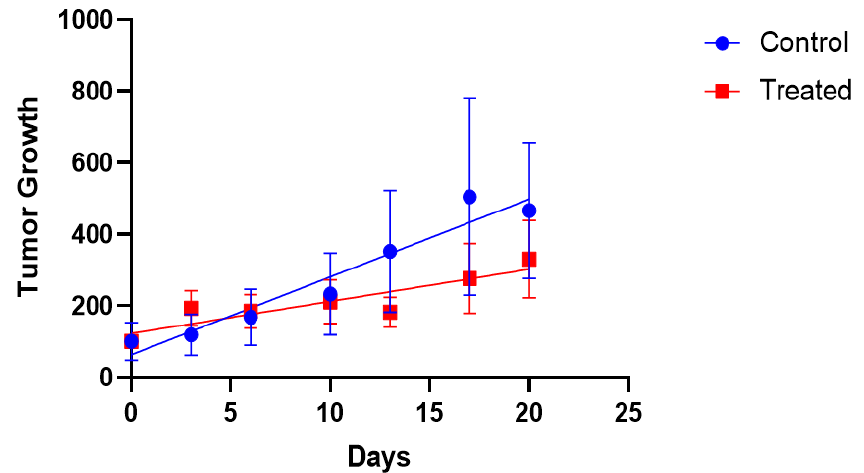
Figure 5. Evaluation of the effectiveness of in vivo treatment with radioactive AuNPs. Tumor size measured in mm 3 . Data are presented as mean values ± SEM ( n = 4/group).